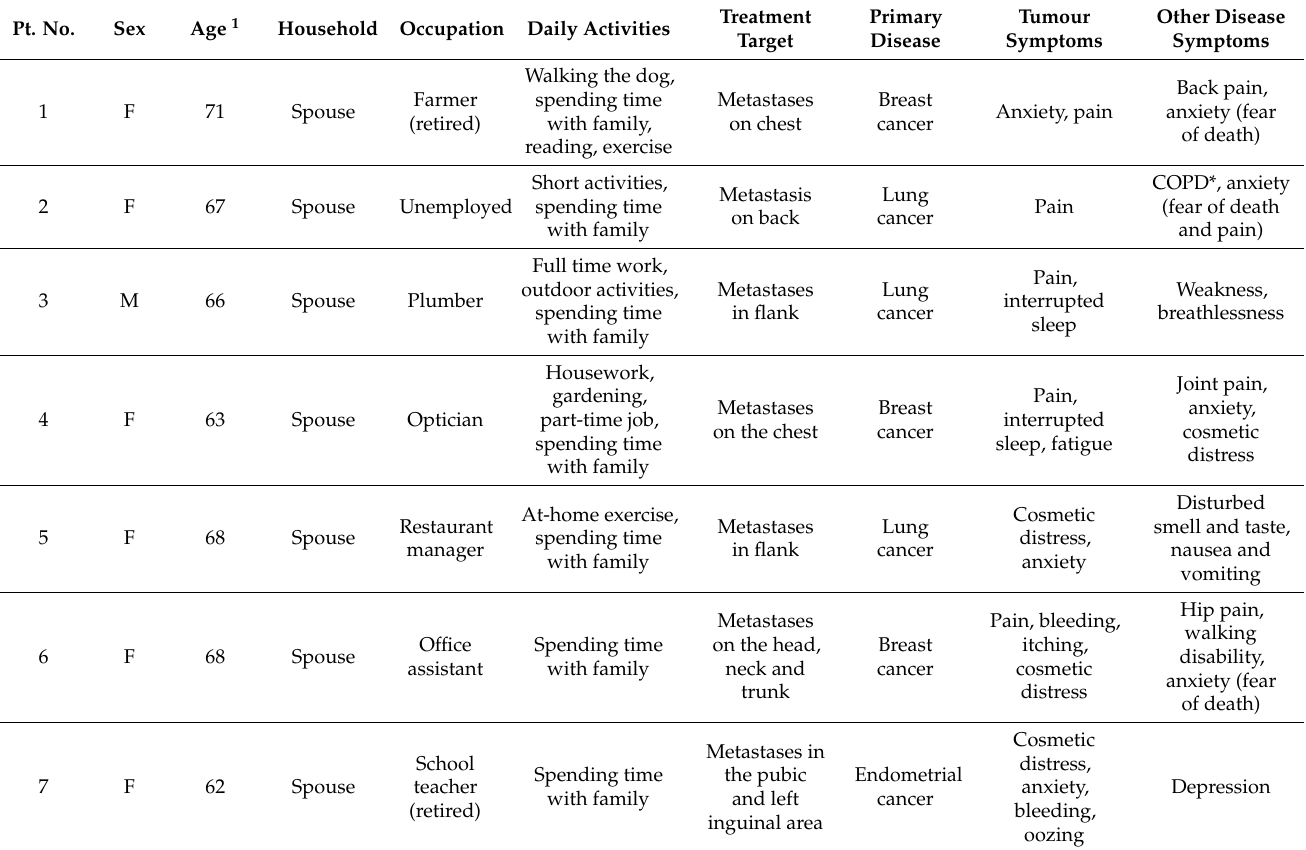
Table 1. Demographics of patients treated with calcium electroporation interviewed at baseline and two